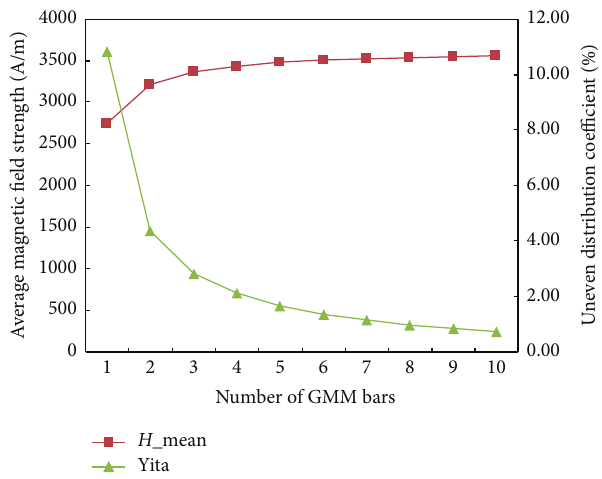
Figure 11: Average magnetic field and uneven distribution coeffi- cient in different GMM bar